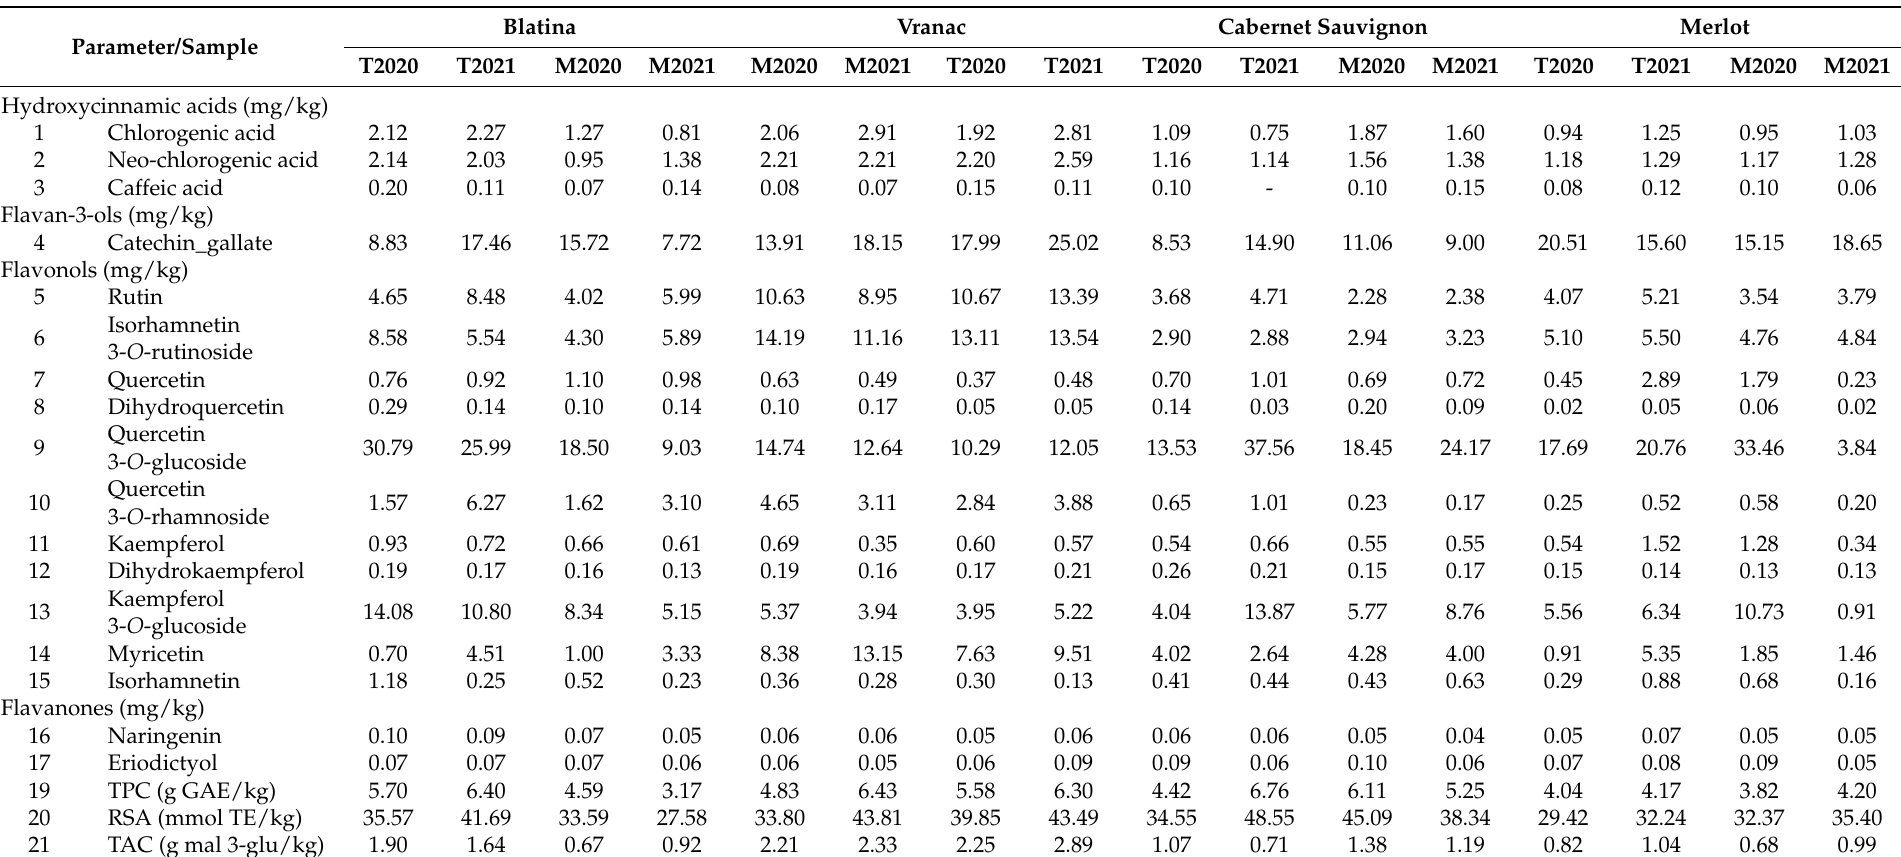
Table 7. Quantitative data on individual polyphenols, total phenolic content (TPC), radical scavenging activity (RSA), and total anthocyanin content (TAC) of frozen grape